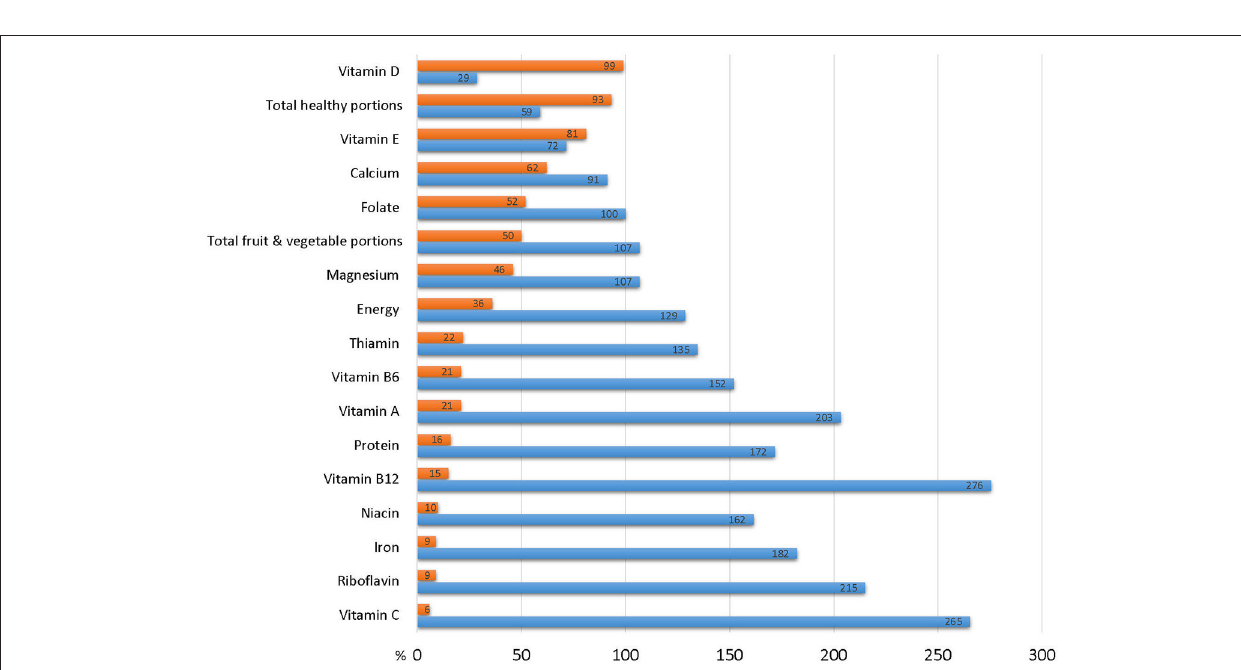
FIGURE 3 | Dietary intake of study participants in in relation to estimated average requirement (EAR). Blue bar represent mean dietary intake of the study cohort expressed as % of EAR. Red bars represent % of survey participants whose habitual diet fails to achieve the EAR.